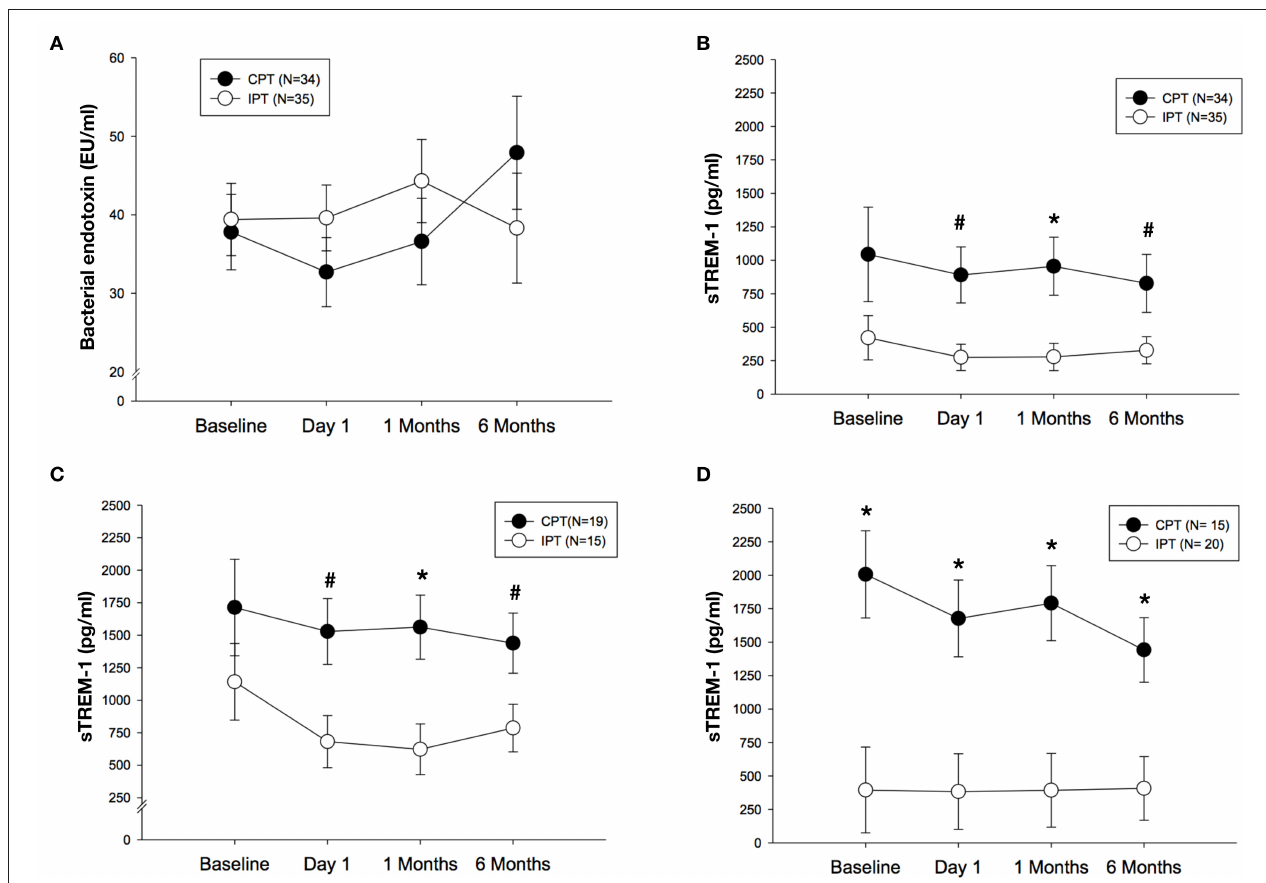
FIGURE 3 | (A) Mean (SE) of bacterial endotoxin (EU/ml) after IPT or CPT during the 6 months randomized trial in the whole population. (B) Mean (SE) of sTREM-1 (pg/ml) after IPT or CPT during the 6 months randomized study in the whole population. (C) Mean (SE) of sTREM-1 (pg/ml) after IPT of CPT in never smokers ( N = 34). (D) Mean (SE) of sTREM-1 (pg/ml) after IPT or CPT in former/current smokers ( N = 35). # p < 0.05 between study groups, * p < 0.01 between study groups.